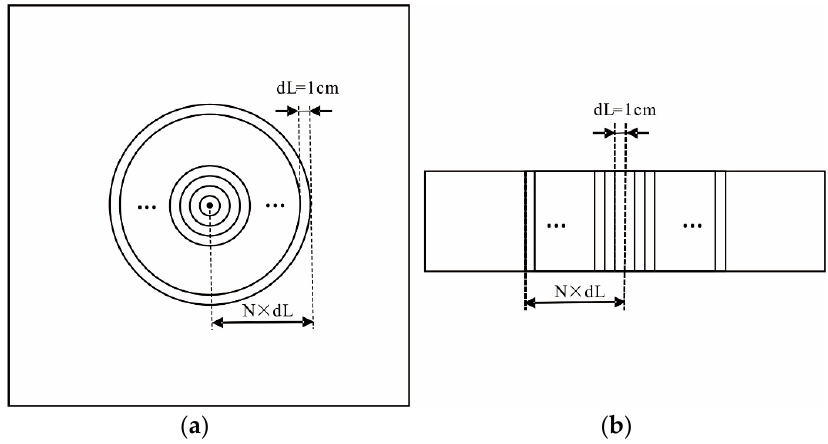
Figure 5. Heating area differential diagram. ( a ) overlooking; ( b ) side view.